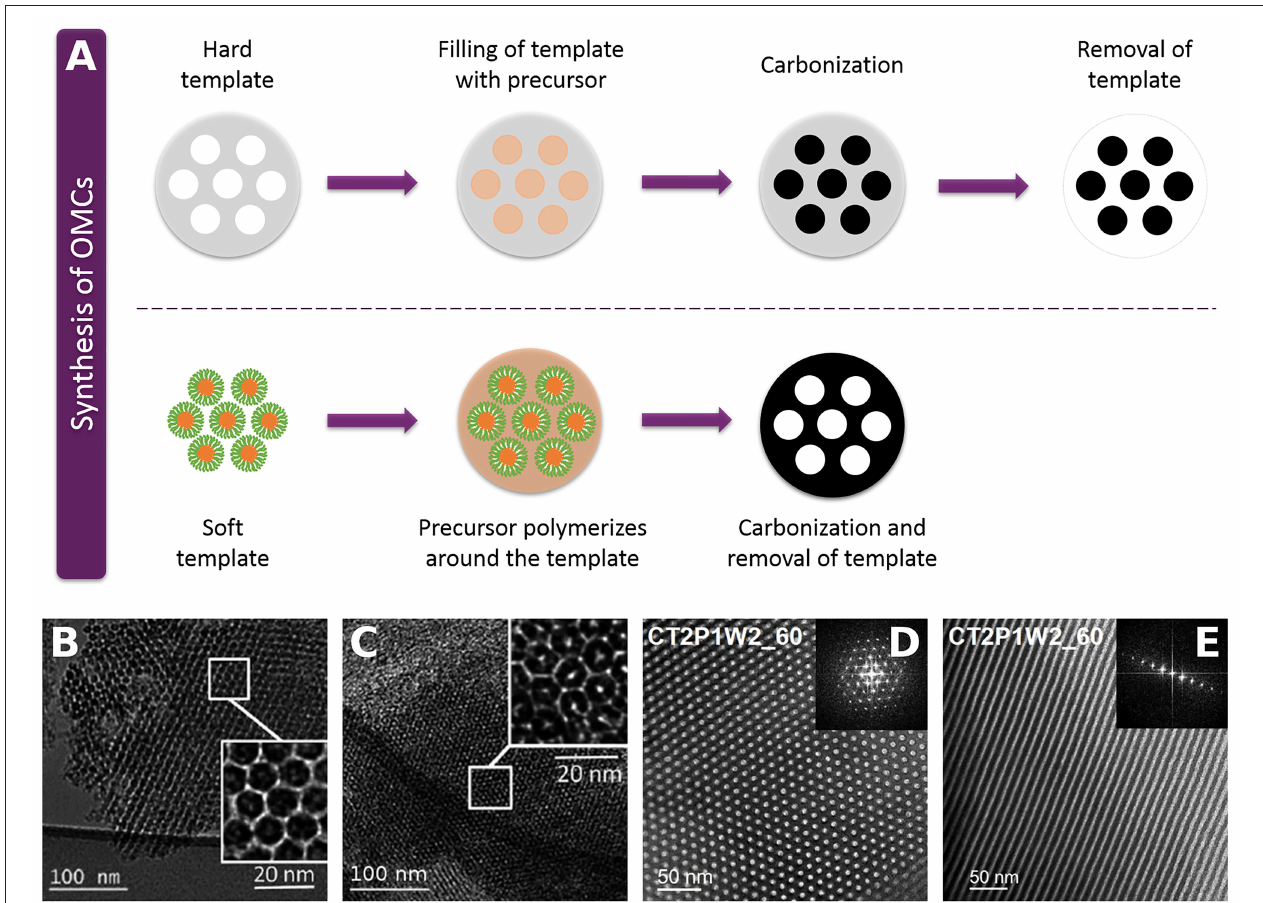
FIGURE 7 | (A) Schematic synthesis of OMCs by hard and soft template methods. (B,C) Hard-templated OMCs using SBA-15 as template and aminobenzoic acid as precursor (Adapted from Sánchez-Sánchez et al., 2016 by permission of The Royal Society of Chemistry). (D,E) Soft-templated OMCs using Pluronic ® F127 as template and mimosa tannin as precursor (Adapted from Castro-Gutiérrez et al., 2018 by permission of The Royal Society of